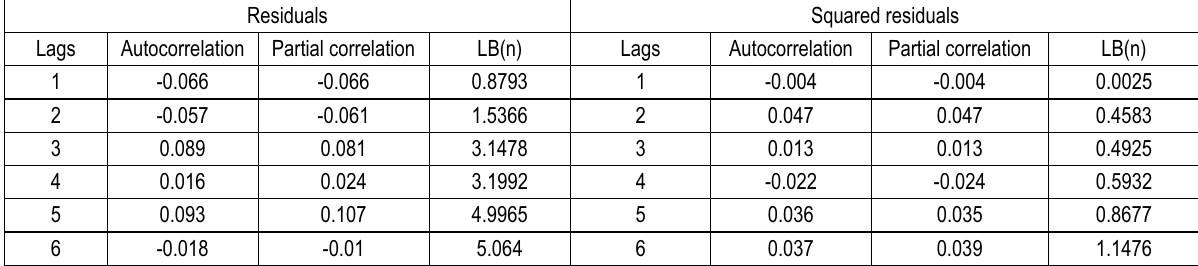
Table 4. Diagnostics on standardized and squared standardized